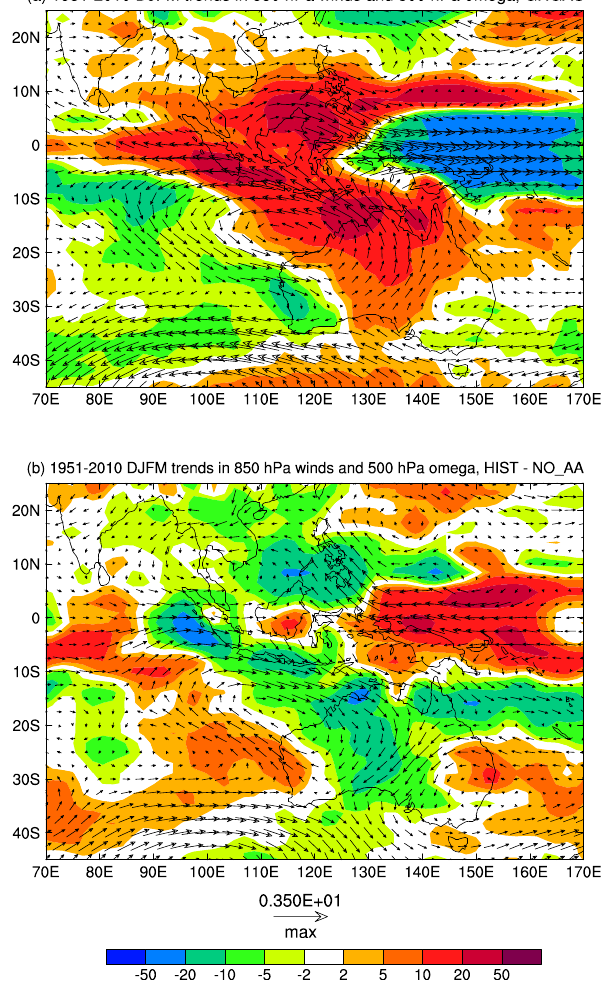
Fig. 17. Simulated 1951–2010 DJFM trends in 850hPa wind vec- tors (ms − 1 century − 1 ) and 500hPa vertical velocity (shading, hPaday − 1 century − 1 ), for (a) GHGAS, (b) HIST minus NO AA. The maximum vector is shown below the